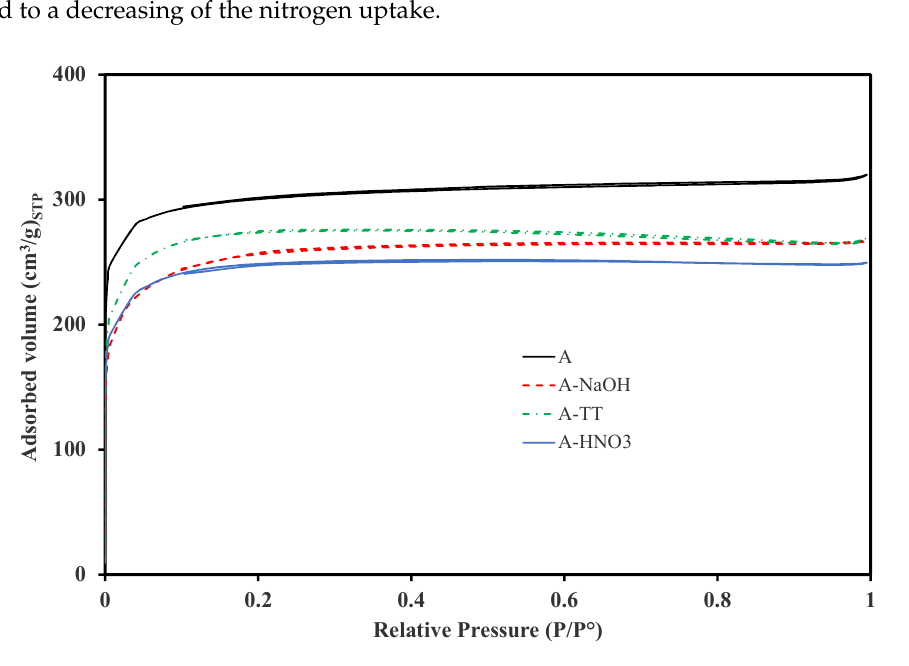
Figure 3. Nitrogen adsorption isotherms obtained at −196 °C for the different AC samples, before (A) and after the surface treatment (A-HNO 3 , A-NaOH and A-TT).